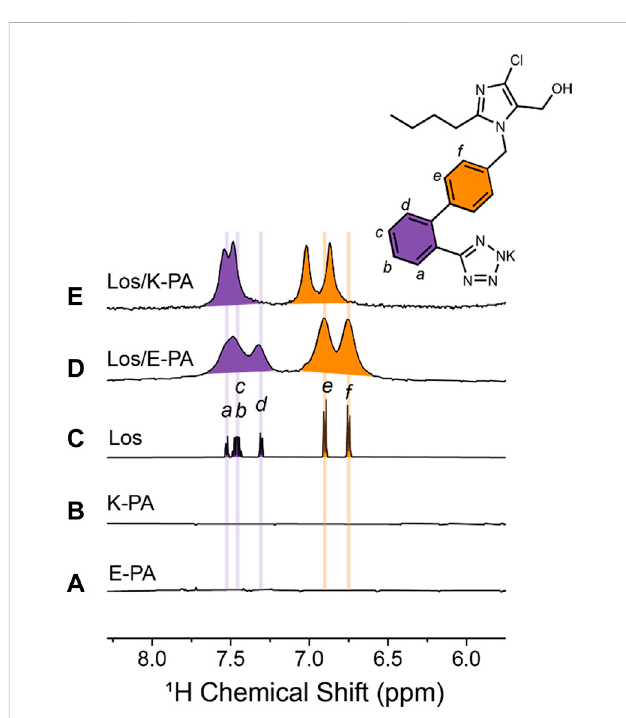
Losartan-PA binding interactions probed by NMR spectroscopy. Region of 1 H NMR spectra measured for (A) 10 mg/mL E-PA, (B) 10 mg/ mL K-PA, (C) 5 mg/mL losartan, (D) 5 mg/mL losartan, and 10 mg/mL E-PA, and (E) 5 mg/mL losartan, and 10 mg/mL K-PA. Note that signals corresponding to aromatic protons are colored purple and orange for ortho- and para-disubstituted benzene rings,